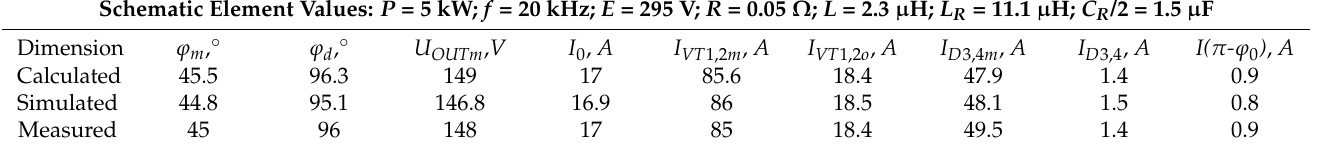
Table 4. Half-bridge RI with ED: design and computer simulations results.